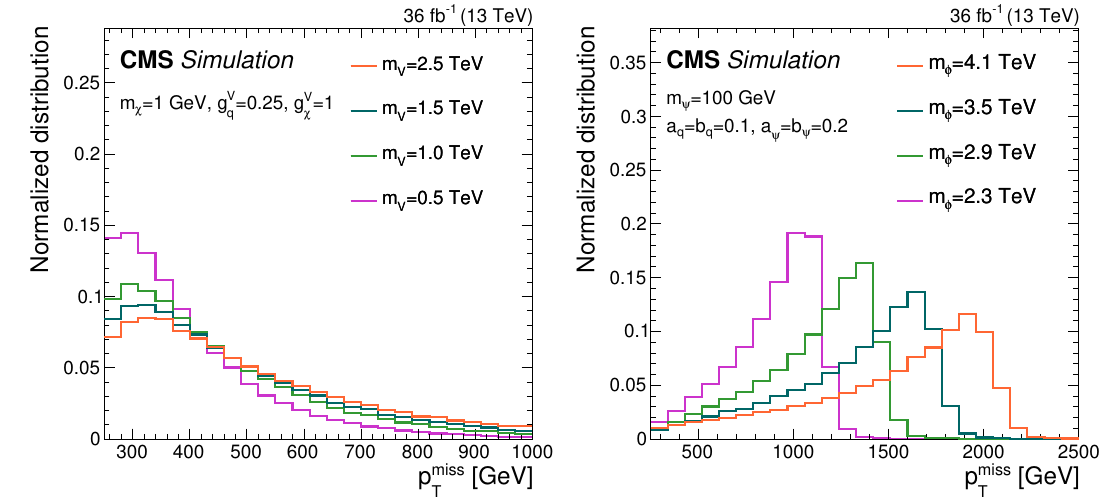
= 0 : 25 and g V = 1 and masses of 1.75 TeV q (cid:31) than the T , the inclusive cross section increases T